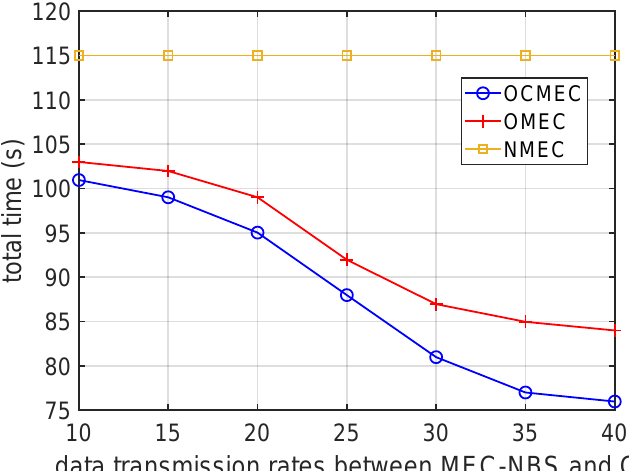
Figure 10. f gained by the 3 schemes with the increase of s BS2NBS rates between MEC-BS and MEC-NBS, k = 1,2, . . . , K .